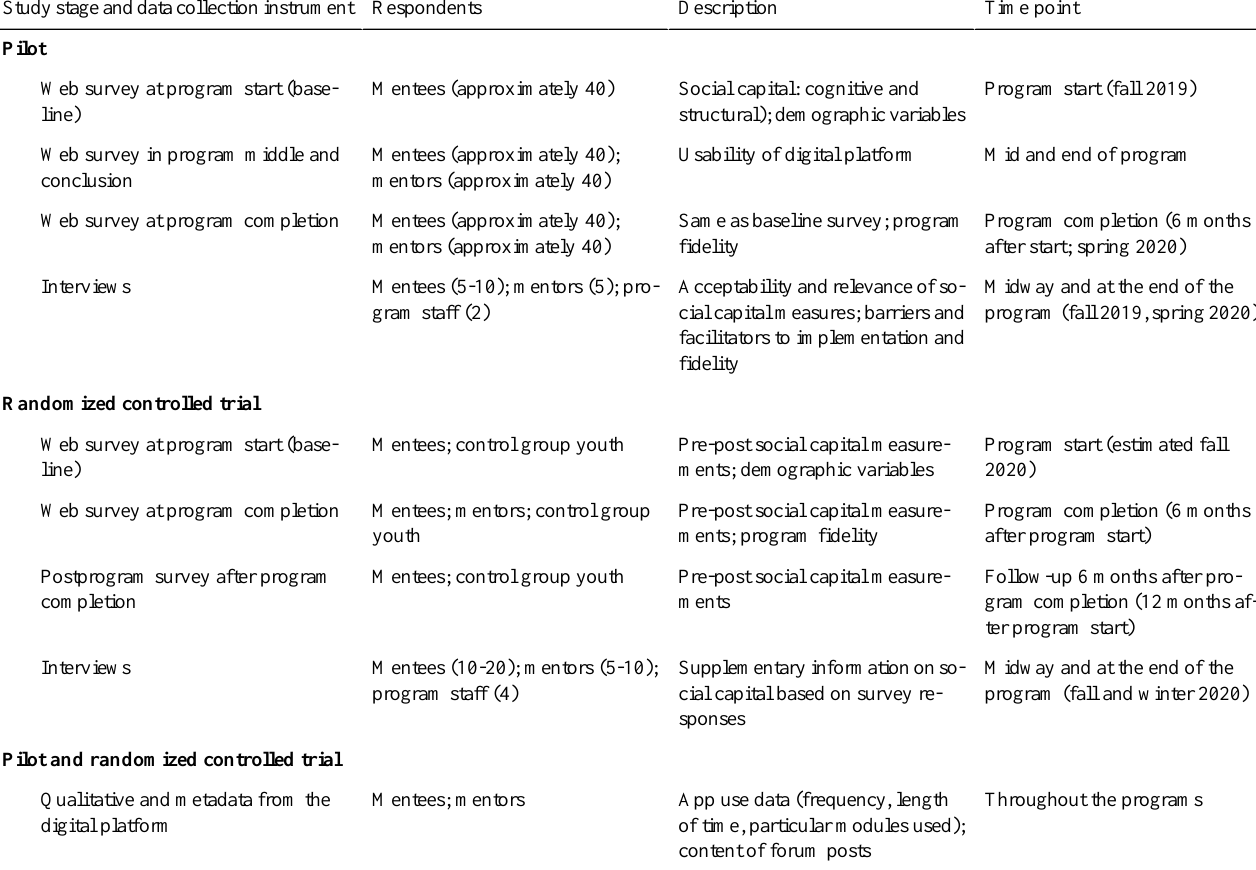
Table 1. Overview of the study